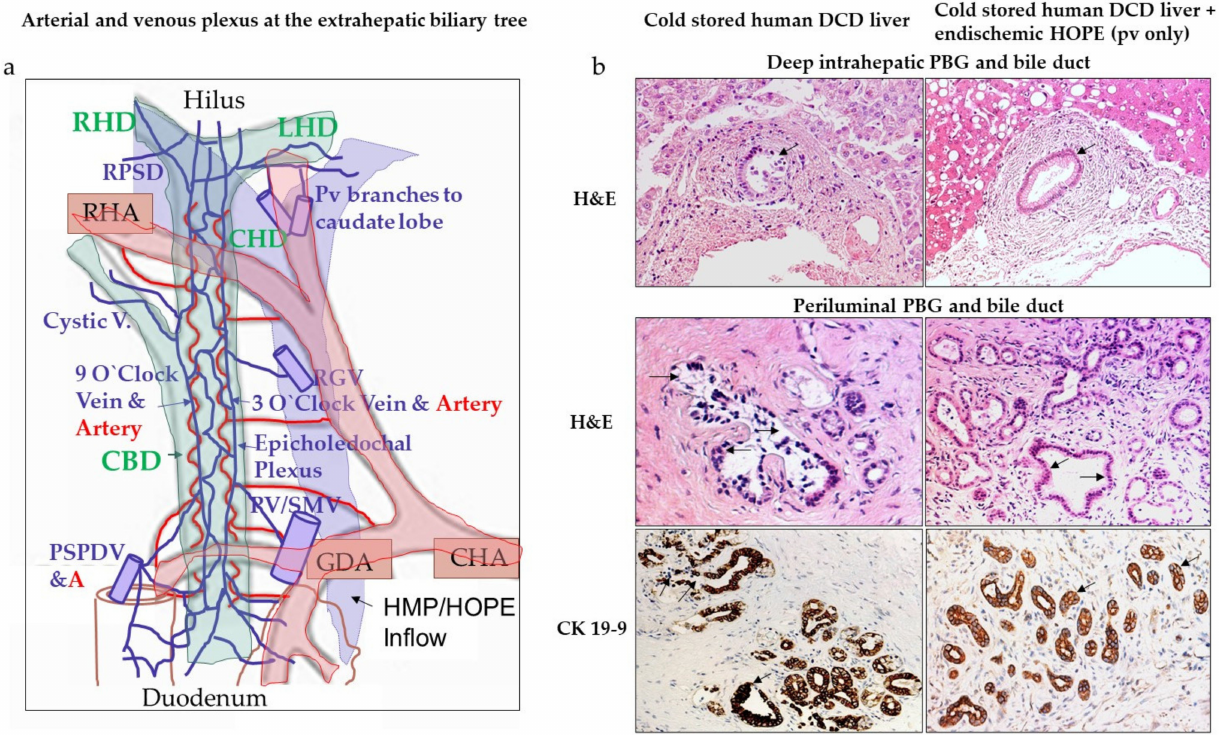
Figure 3. Vascular plexus of the extrahepatic biliary tree and histology after transplantation of cold stored and HOPE- treated human DCD liver grafts. Branches from both hepatic artery and venous vessels feed the vascular plexus around the extrahepatic biliary tree, all regional arteries, and veins, including the portal vein (PV) and supra-mesenteric vein (SMV) contribute to the vascular supply ( a ). Histology of deep intrahepatic and periluminal PBG and bile duct in HE and Cytokeratin 19-9 comparing cold stored human DCD livers with HOPE-treated grafts after implantation. HOPE treatment protected the cholangiocellular lining in the ducts by administration of oxygen in the cold fluid through the vascular plexus of the common hepatic and common bile duct ( b ). CBD: common bile duct; CHD: common hepatic duct; CHA: common hepatic artery; GDA: gastroduodenal artery; RGV: right gastric vein; PBG: peribiliary glands; PSPDV + A: posterior pancreatico-duodenal vein and